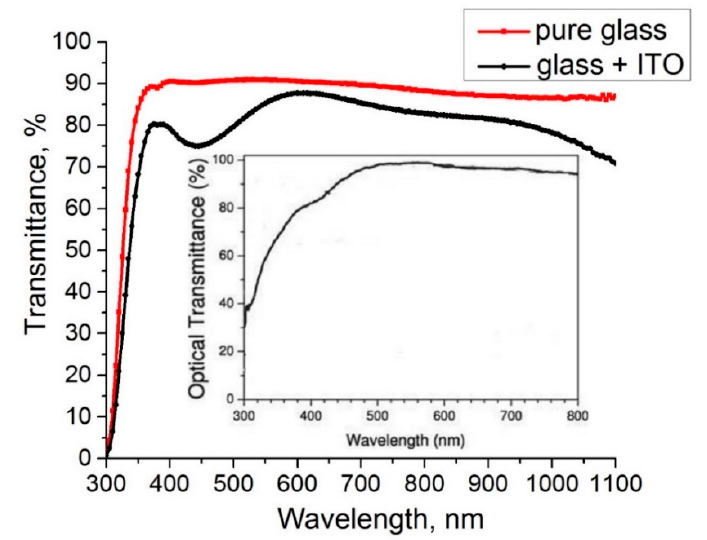
Figure 2. Measured transmittance characteristics of the commercial ITO on glass. The inset represents the absolute transmittance of ITO presented by the manufacturer [16].